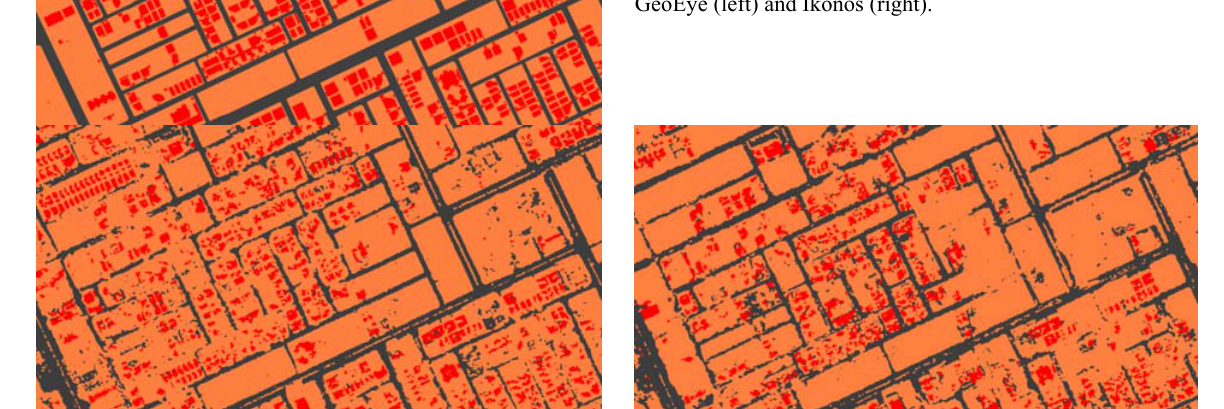
Figure 7: Upper row: GeoEye (left) and Ikonos (right) image. Middle row: Reference label image (red: building; orange: ground, dark: street). Lower row: Classification results, GeoEye (left) and Ikonos